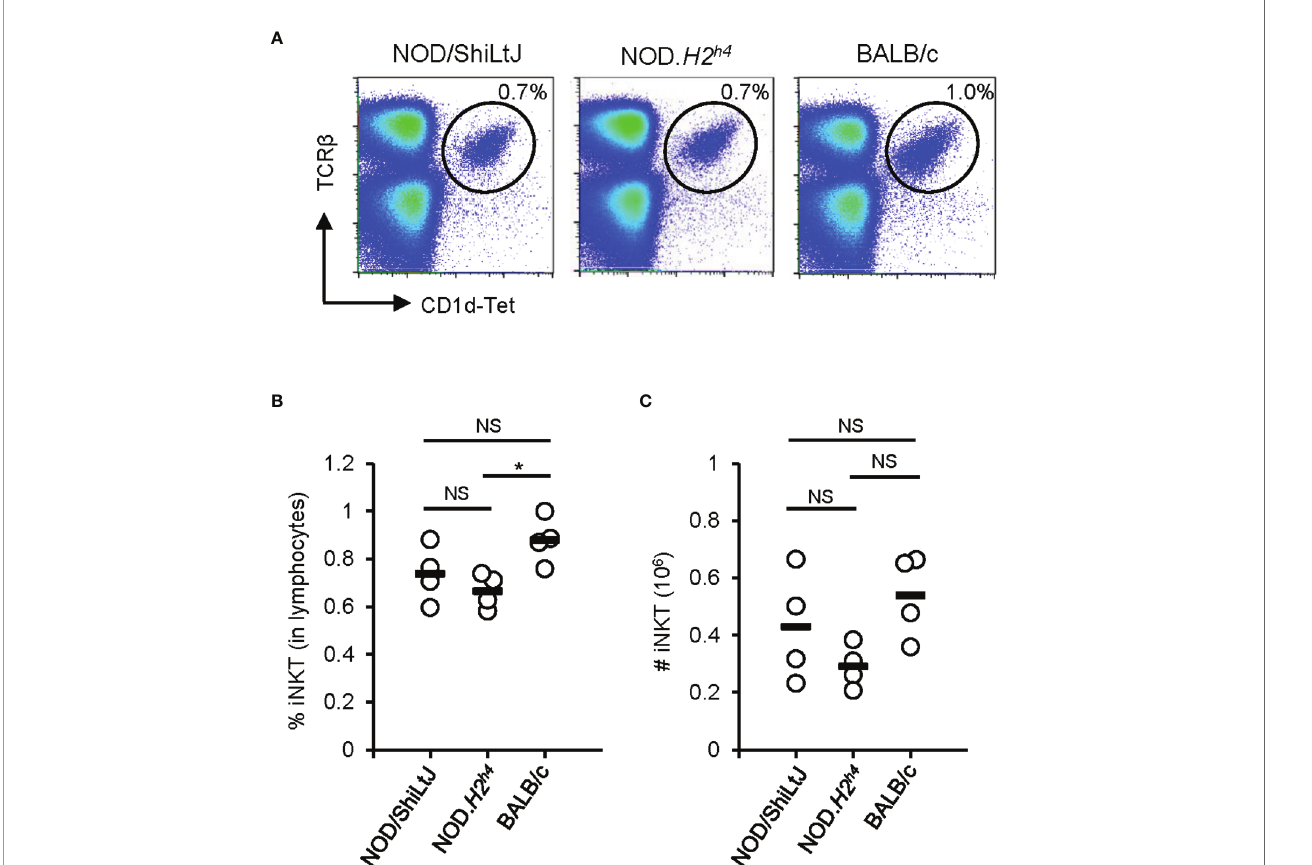
FIGURE 2 | iNKT cell abundance in the spleen. Spleen of NOD/ShiLtJ, NOD. H2 h4 , and BALB/c mice were stained with antibodies to TCR b and with CD1d tetramer (NIH Tetramer Core Facility). Data was acquired on BD FACSCanto II fl ow cytometer and analyzed with FlowJo. (A) Representative fl ow cytometry pro fi les of iNKT (TCR b + CD1d-Tet + ) cells in the spleen of NOD/ShiLtJ, NOD. H2 h4 , and BALB/c mice. (B) Compilation of the percentage of iNKT cells in the spleen of NOD/ShiLtJ, NOD. H2 h4 , and BALB/c mice (n = 4). (C) Compilation of absolute number of iNKT cells in the spleen of NOD/ShiLtJ, NOD. H2 h4 , and BALB/c mice (n = 4). One-way ANOVA tests were performed for statistical analysis. Non-signi fi cant, NS; P- value > 0.05, and *; P -value =